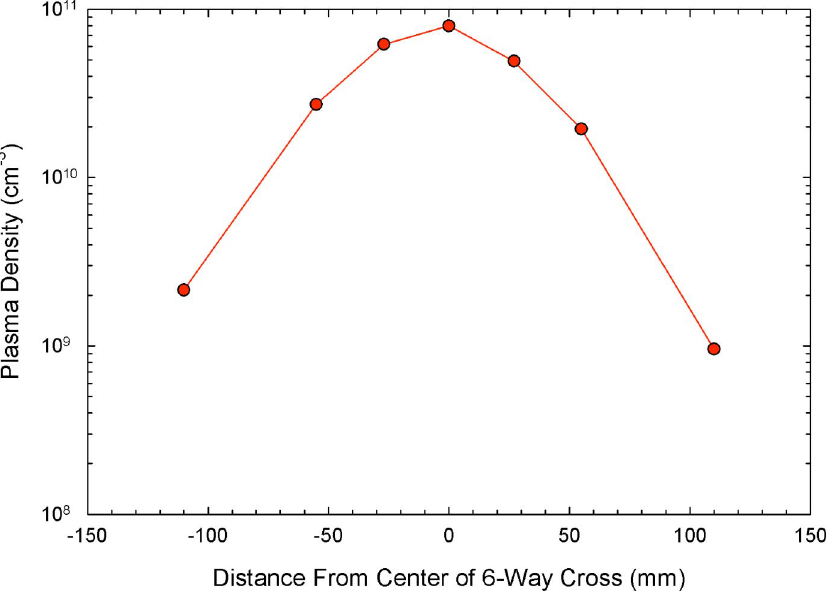
FIG. 32. (Color) Plasma density profile transverse to the plasma source in the six-way